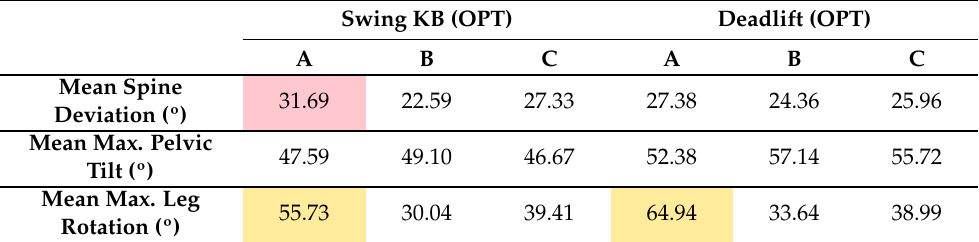
Table 3. Mean values for levels of experience (lower back flexion >30 ◦ in red and leg rotation >50 ◦ in yellow).